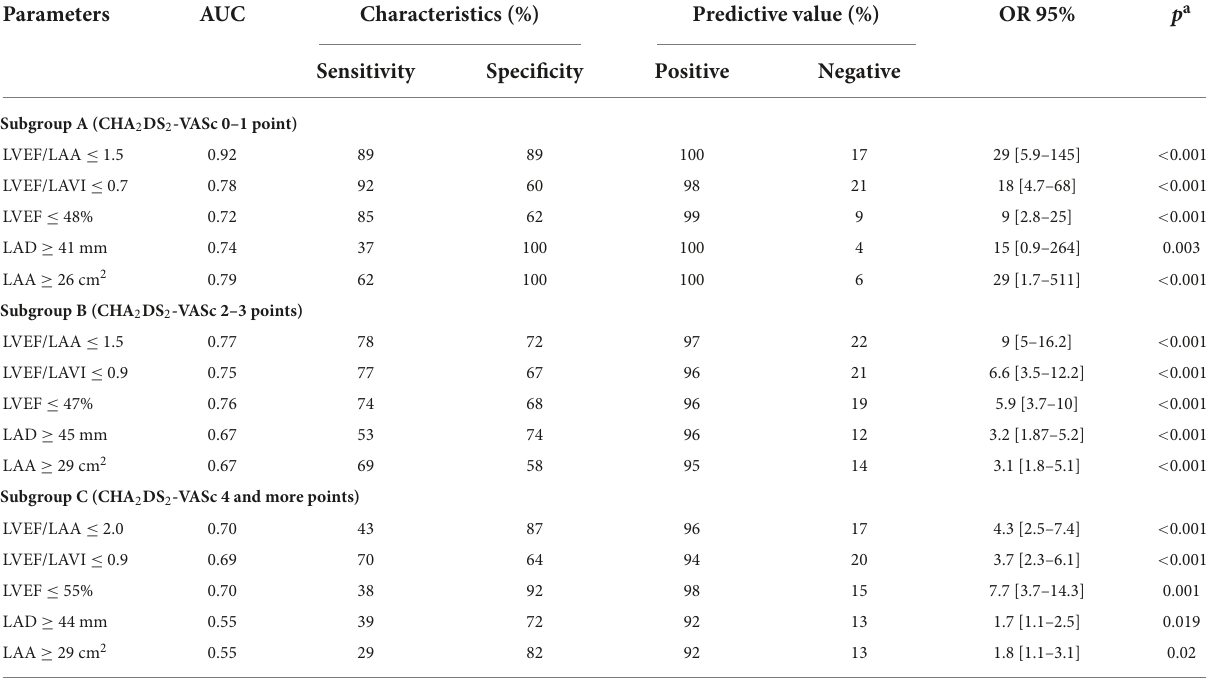
TABLE 5 Accuracy of echocardiographic indices in LAAT prediction according to CHA 2 DS 2 -VASc score values.